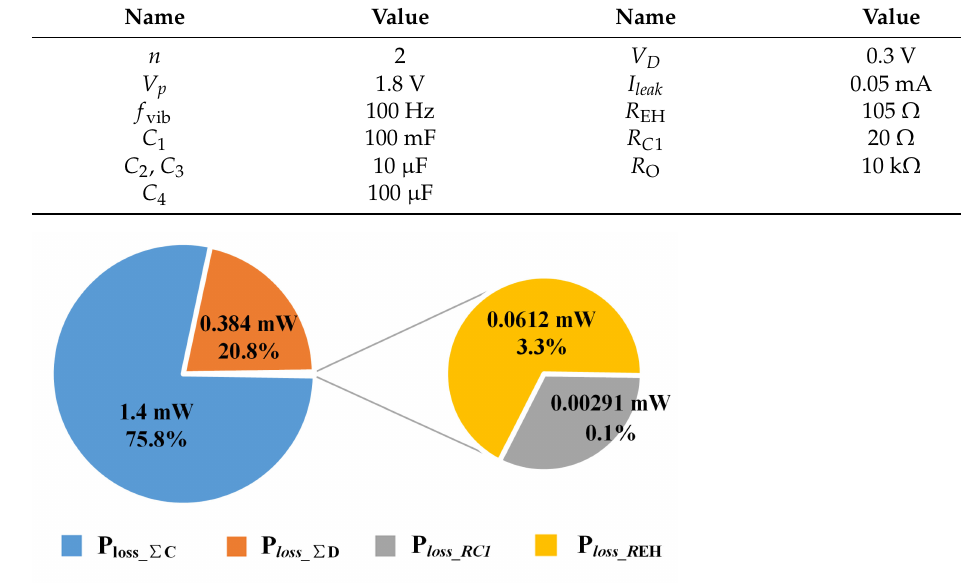
Figure 13. Power loss distributions of a two-stage VM circuit.